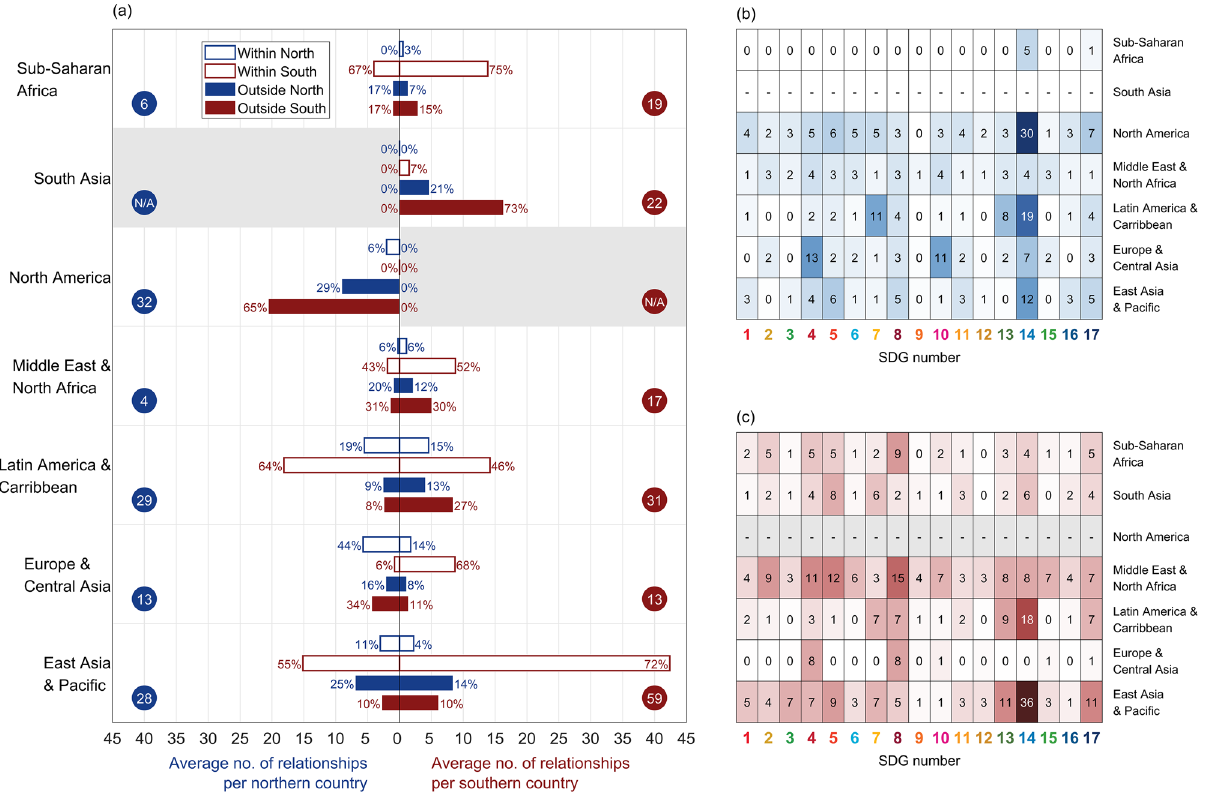
Figure 6. Comparison of the average number of country-wise relationships. For: ( a ) Northern countries or Southern countries in different World Bank regions (blue or red circles), separated into relationships between partners in different Northern or Southern countries (blue or red bars), within or outside each region (transparent or filled bars), where the number at the end of each bar is the percentage of that type of relationship within that region; ( b ) Northern countries in different World Bank regions by SDG; and ( c ) Southern countries in different World Bank regions by SDG. Larger versions of the components of this figure are included in Supplementary